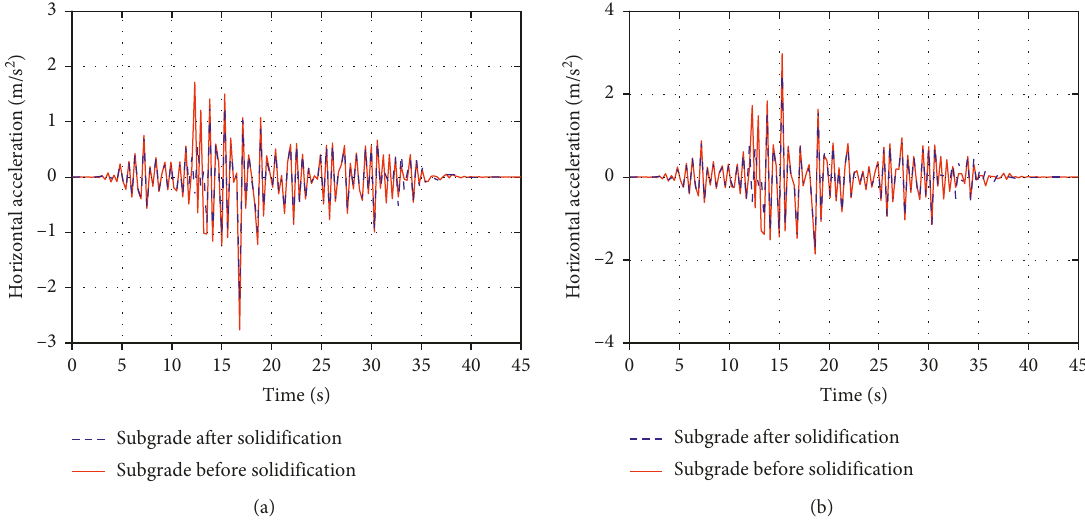
Figure 19: Horizontal acceleration time histories of the right slope top and slope toe. (a) Slope top. (b) Slope toe.